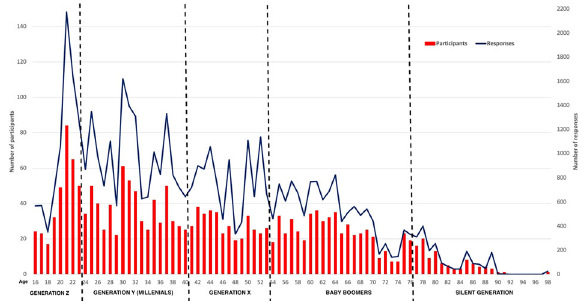
Fig. 1 The number of participants for each age year in the sample (in red; left axis). The number of unique elicited responses, color descriptors for the corresponding age year is in blue (right axis).